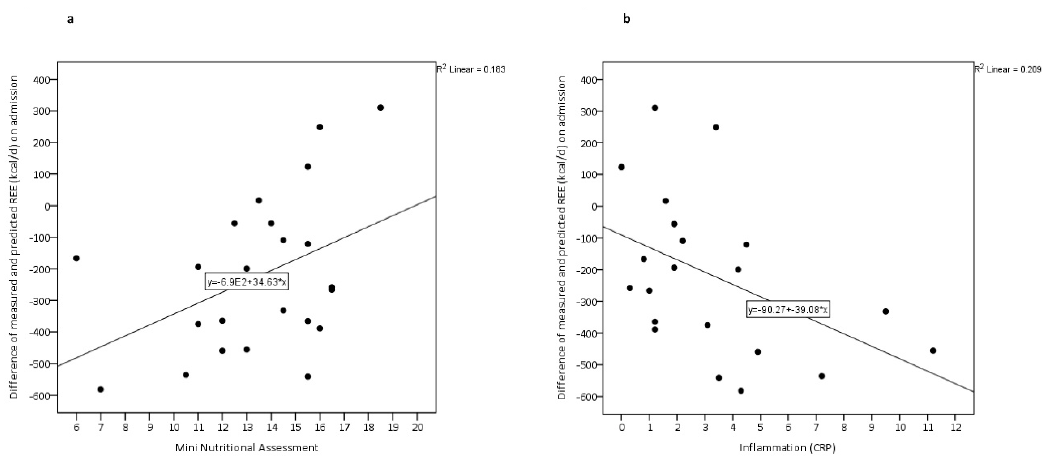
Figure 1. Associations between differences of measured and predicted resting energy expenditure (REE) on admission and ( a ) Mini Nutritional Assessment Long Form and ( b ) inflammation (CRP, C-reactive protein). The solid line is the regression line. REE was measured by indirect calorimetry and predicted by the Harris–Benedict equation.